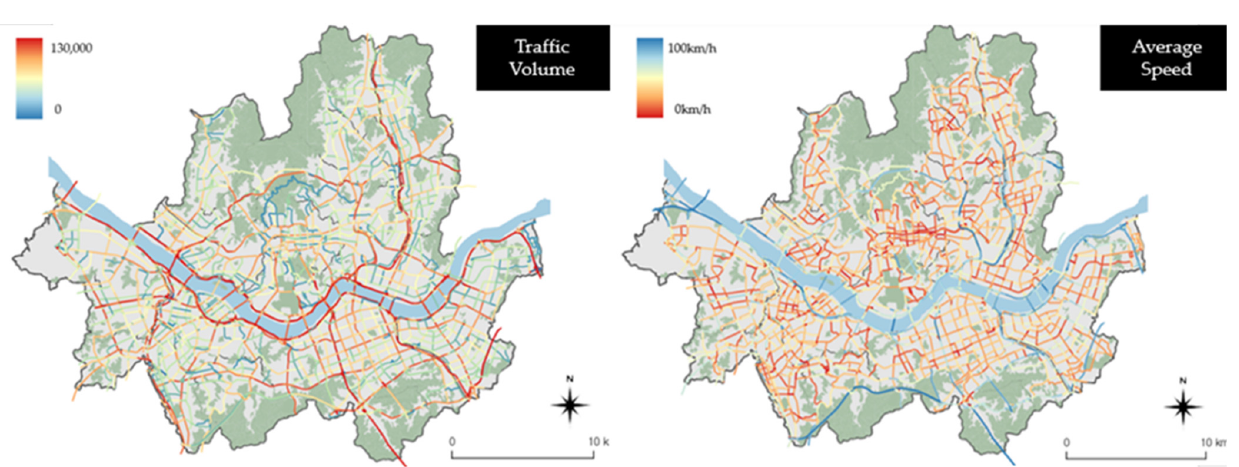
Figure 4. Seoul’s traffic volume and average speed by autonomous districts ( Gu ). Figure 3. Seoul’s traffic volume (left) and average speed (right) by the link units.